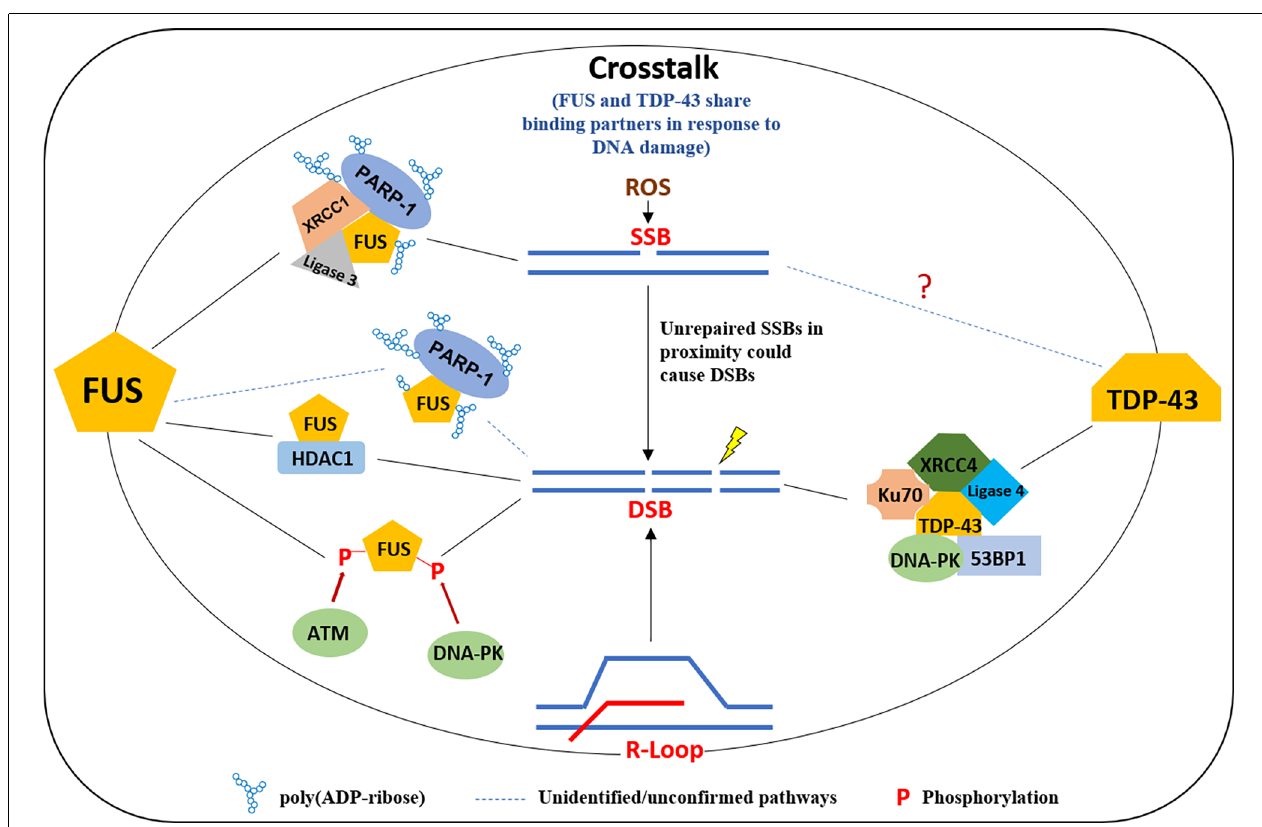
FIGURE 2 | A model of multifaceted involvement of FUS and TDP-43 in the DNA damage response. FUS is recruited to DNA damage sites in a PARP1 activity-dependent manner in response to DNA SSB and forms a complex with XRCC1 and Ligase 3 and is required for ligation activity of Ligase 3. FUS is also involved in DSB repair by interacting HDAC1 or the phosphorylation by ATM/DNA-PK. TDP-43 plays a scaffold protein role at DSB in binding with XRCC4, Ligase 4, Ku70, DNA-PK, and 53BP1, for an efficient DNA repair in NHEJ. FUS, fused in sarcoma; TDP, TAR DNA binding protein; PARP, poly(ADP-ribose) polymerase; DSB, double-strand